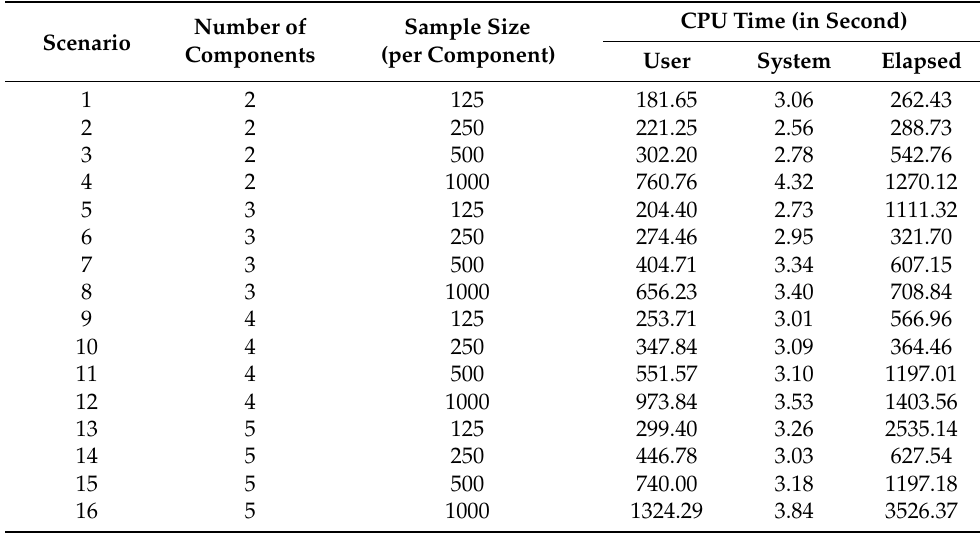
Table A1. Report the CPU time for simulation